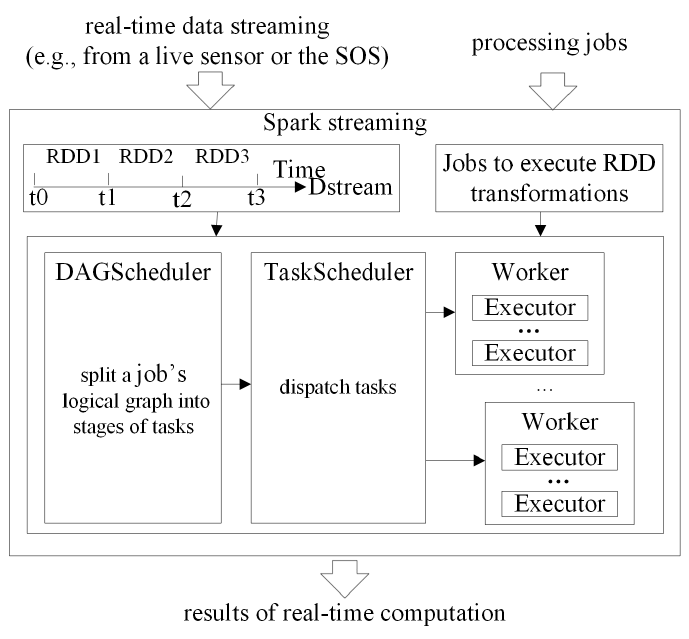
Figure 4. The core processes of integrating the WPS with Spark.